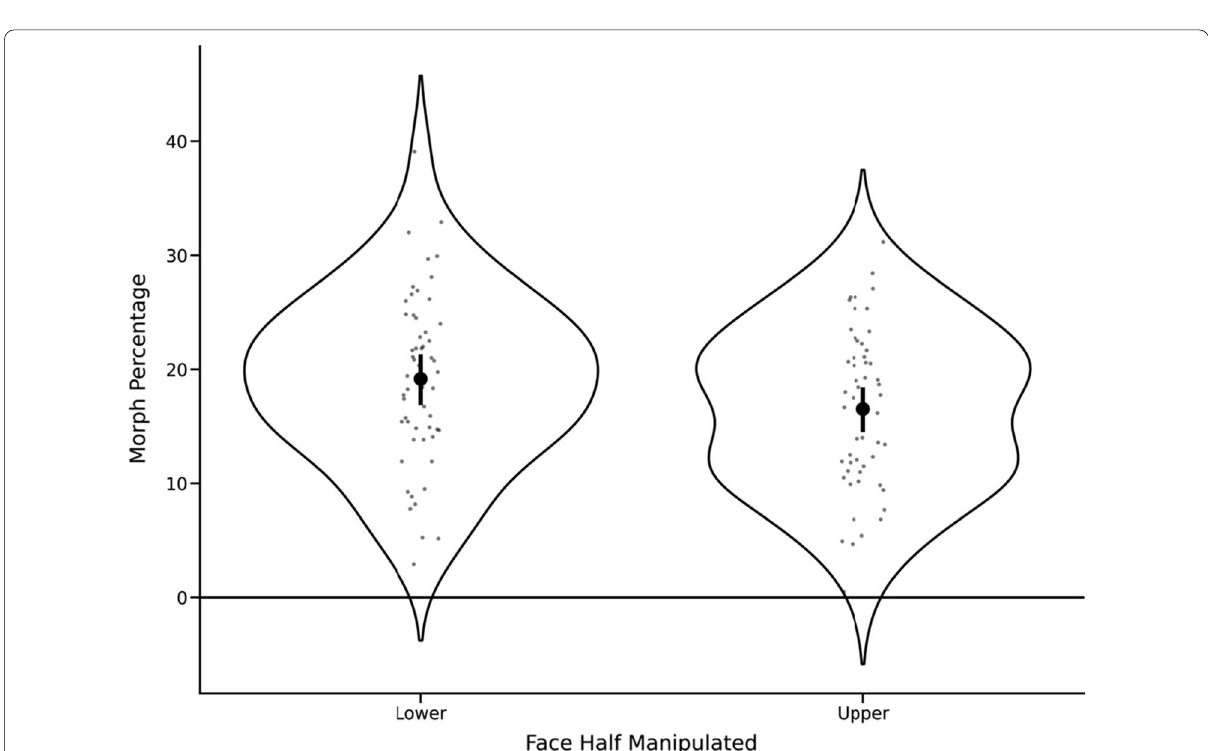
Fig. 3 Violin plots illustrating the distributions of the morph percentages for both experimental conditions. Black dots and bars represent the means and 95% confidence intervals, respectively. Grey dots represent the individual participant means. The horizontal line represents a morph percentage of zero, i.e., the original, unaltered version of the